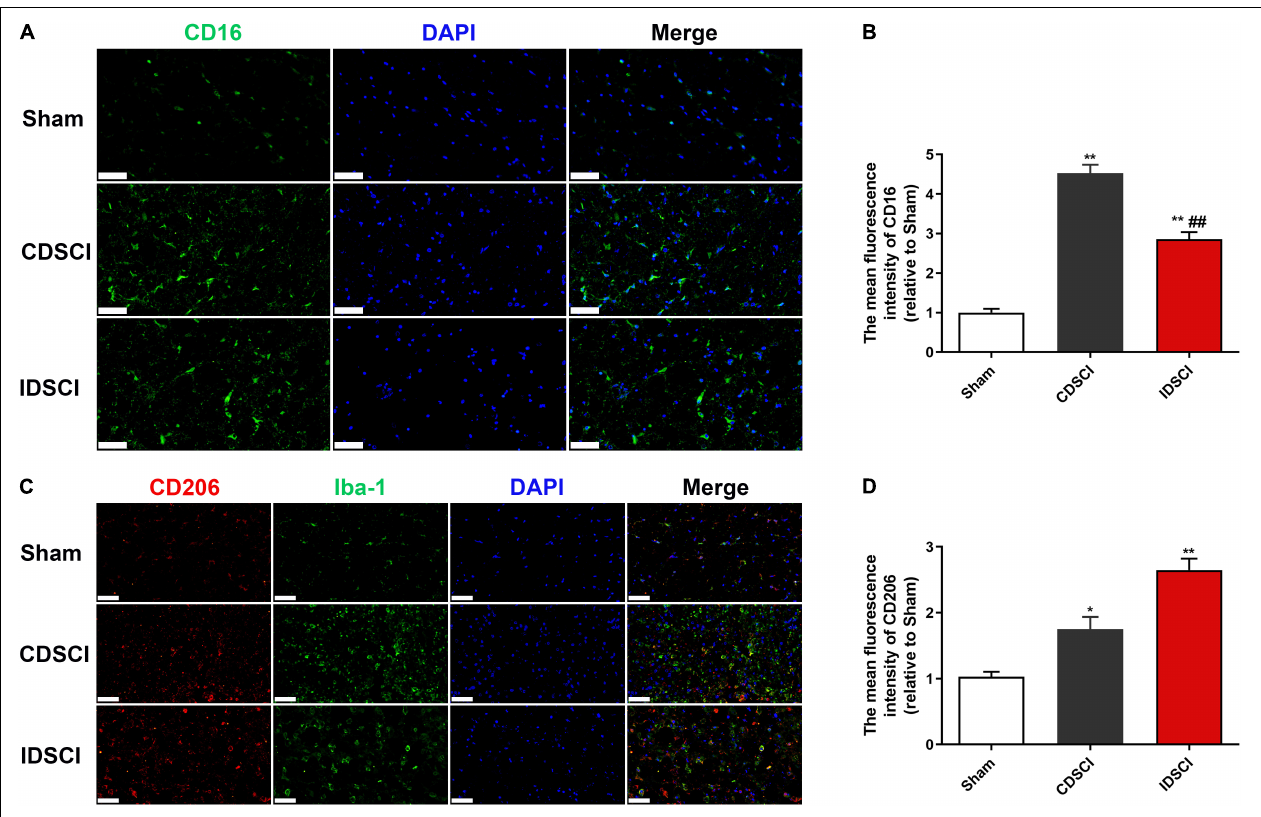
FIGURE 5 | Expression levels of M1/M2 microglia/macrophage polarization markers in the spinal cord tissues after DSCI. (A,C) Representative immunostaining images of CD16 (green), CD206 (red), Iba-1 (green) and DAPI (blue) in the spinal cord tissues at day 7 post-surgery (scale bar = 50 µ m). (B,D) The mean fluorescence density of CD16 and CD206 quantification in the aim field was measured ( n = 3). All values are expressed as means ± SD. * P < 0.05, ** P < 0.01 vs. the sham group; # P < 0.05, ## P < 0.01, vs. the CDSCI